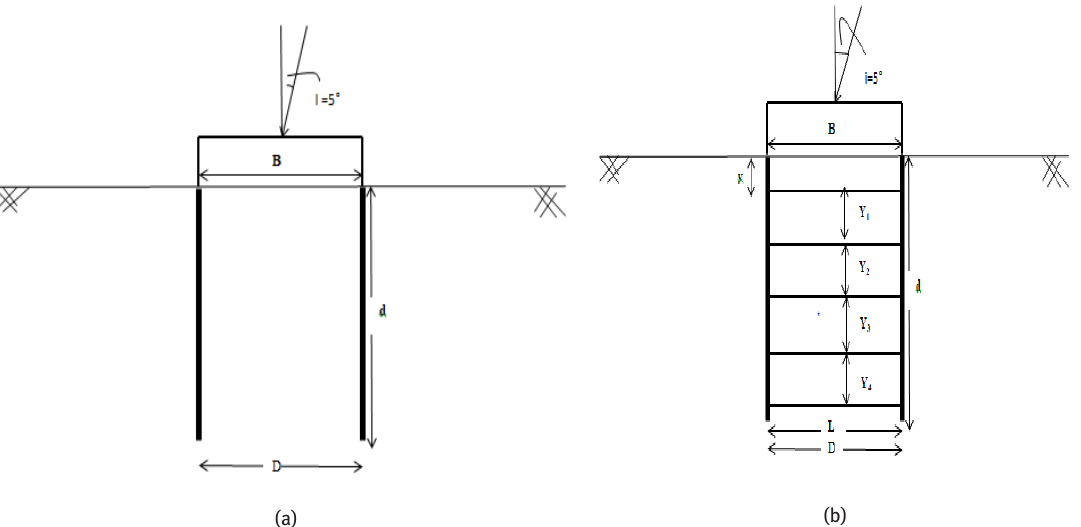
Figure 4: Schematic presentation of footing with (a) confiner (b) confiner with reinforcements under centric inclined load.